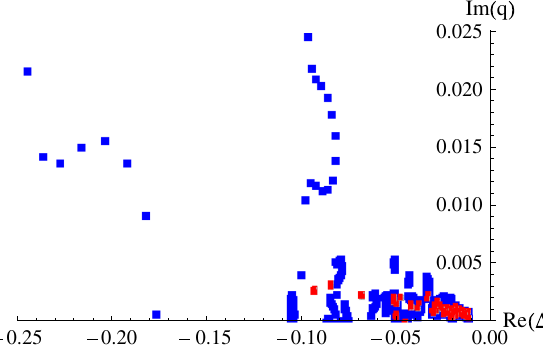
FIG. 7. The same as the figure above but for the fractional eigenvalues Δ q ¼ q − Round ½ q (cid:2) entering into the stability condition, Eq. (24).